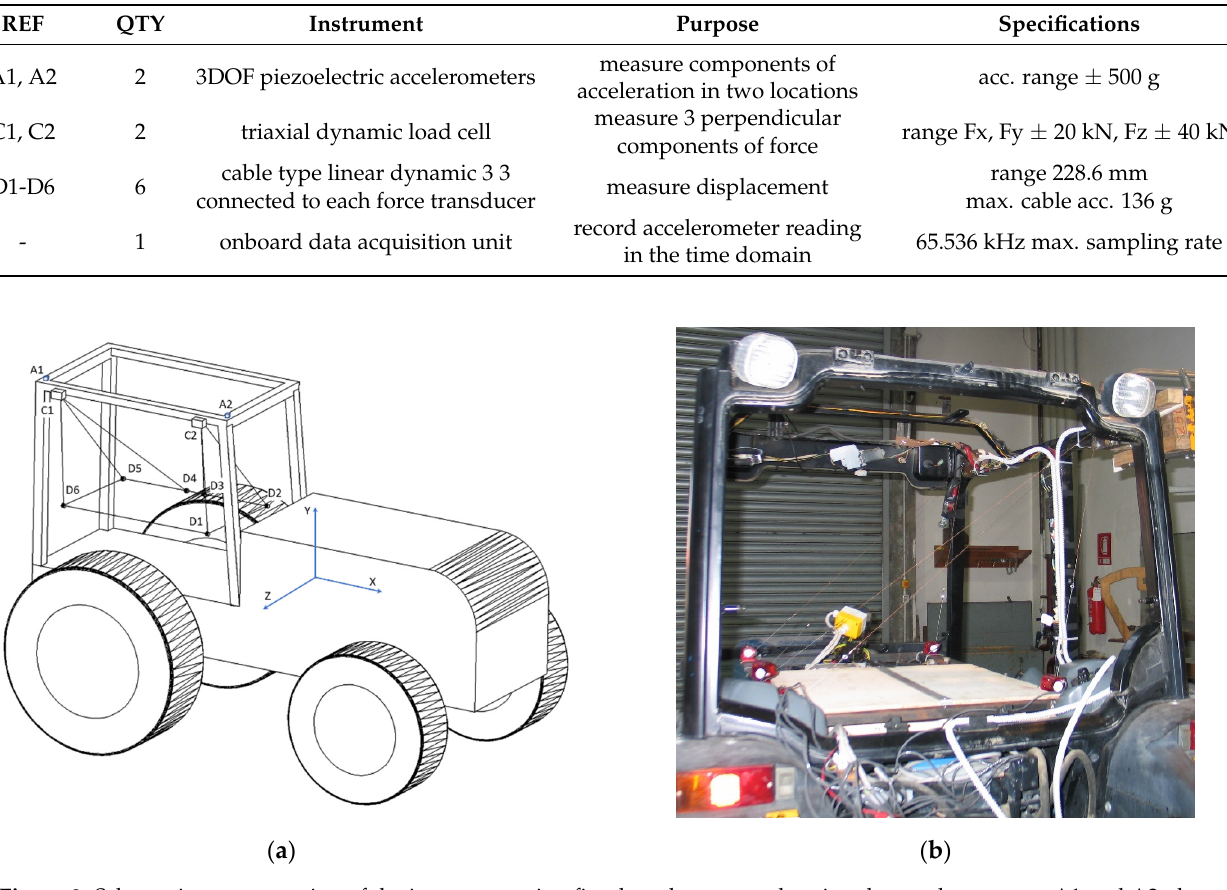
Figure 3. Schematic representation of the instrumentation fitted on the tractor showing the accelerometers, A1 and A2, the load cells, C1 and C2, and the linear displacement transducers, D1–D6, connected to the load cells ( a ) and actual system ( b ). Table 2. Data acquisition system components of the test tractor.